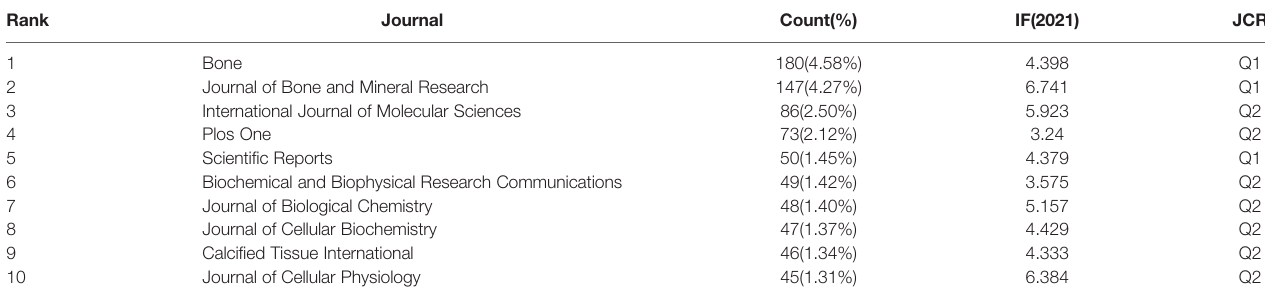
Frontiers in Endocrinology |